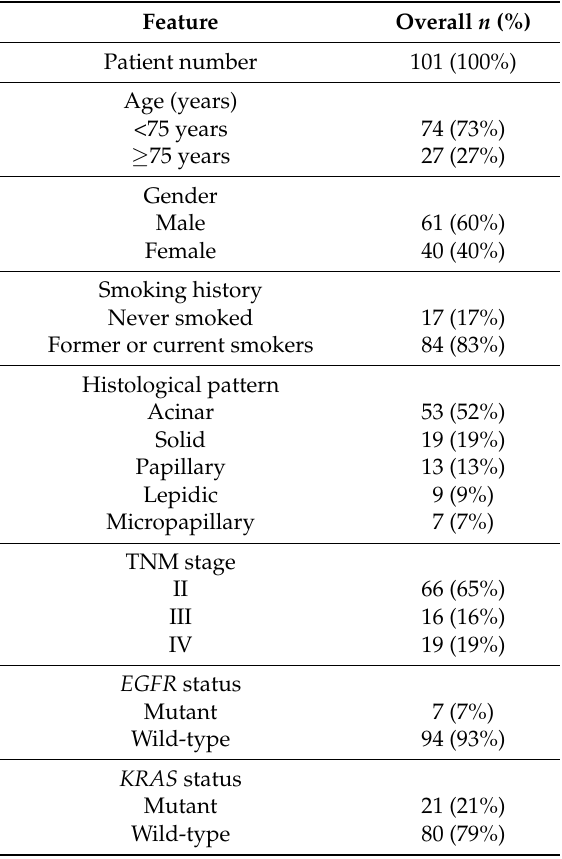
Table 3. Clinical and histopathological characteristics of the 101 LADC patients included in the